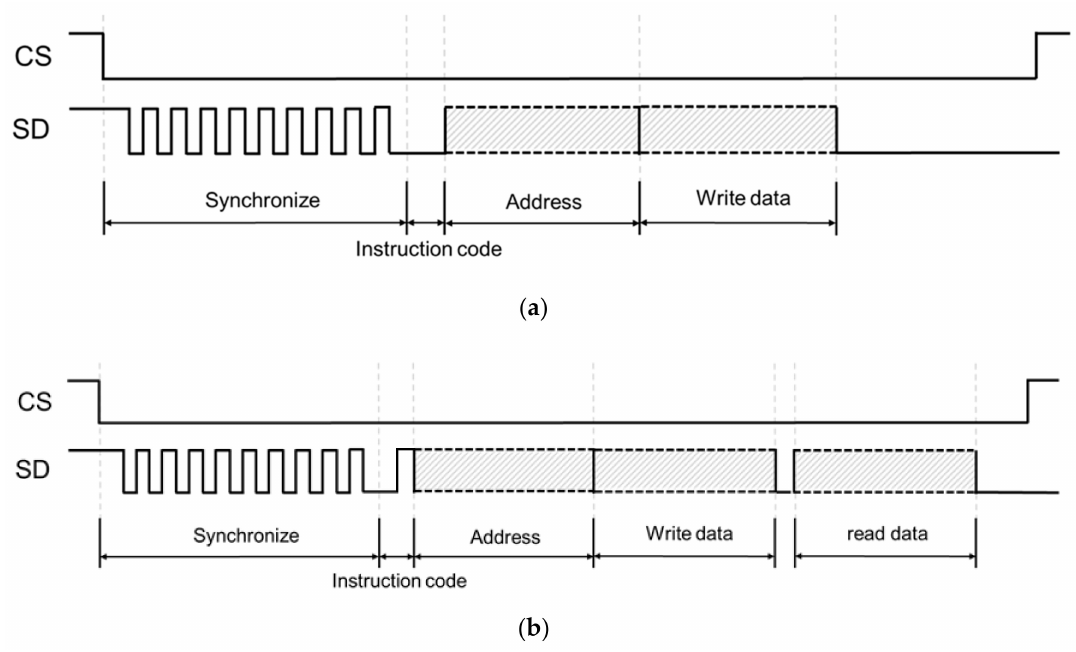
Figure 8. The low-power synchronous preamble data line protocol operation waveform: ( a ) the waveform of writing data, and ( b ) the waveform of reading